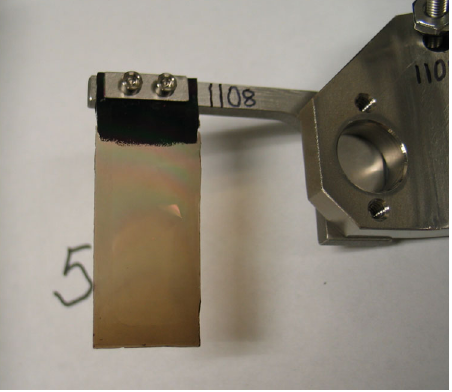
FIG. 9. Photo of the SNS 4th generation foil assembly.